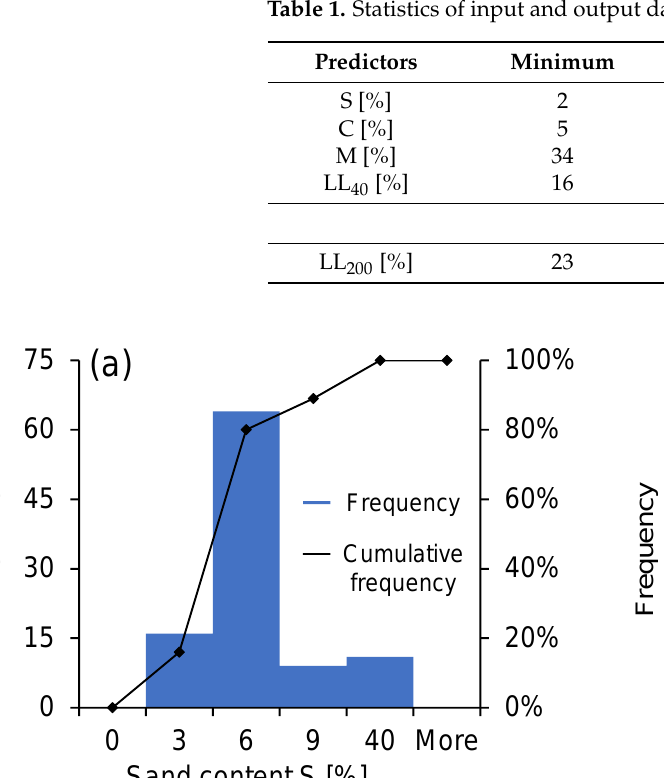
Table 1. Statistics of input and output data for LL 200 prediction model.